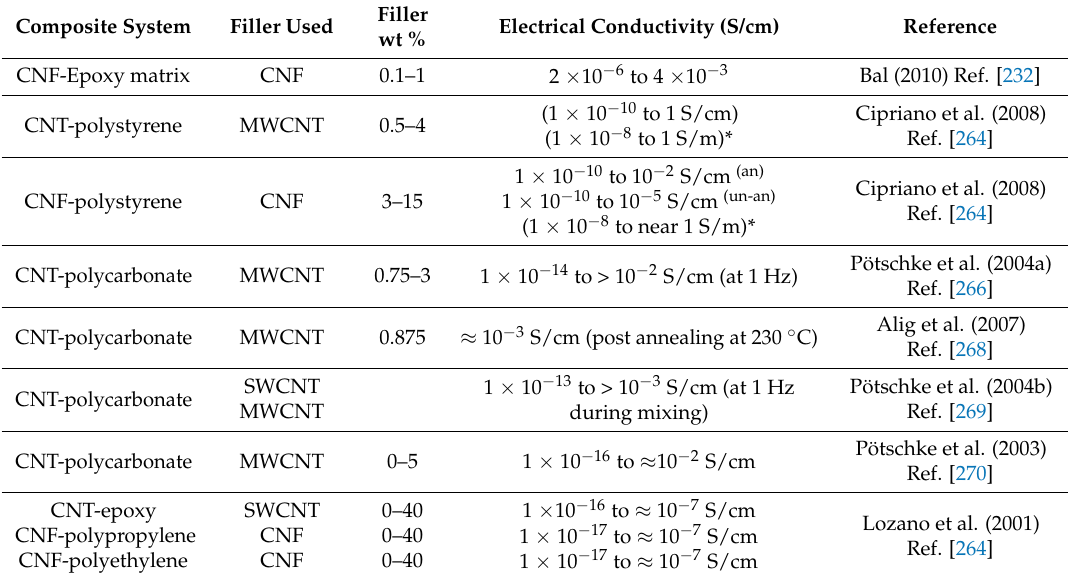
Table 2. Table of reported values of electrical conductivity for modified carbon-epoxy composites (* denotes conductivity values reported in S/m: an and un-an denotes measurements on annealed and un-annealed samples; where a frequency is indicated conductivity values were read from the conductivity spectra at the indicated frequency). CNF: carbon nanofiber; MWCNT: multi-walled carbon nanotube; SWCNT: single-wall carbon